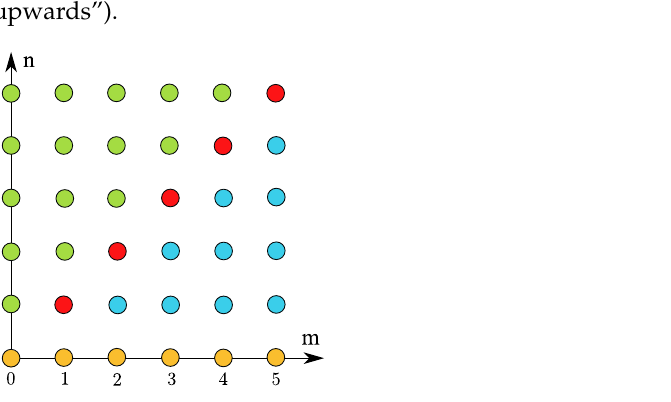
Figure 4. Topological phase diagram of the system described by the Hamiltonian (1) characterized by the “winding number” C , given by Equation (20), depending on parameters ( n , m ) ∈ { 0,1,2,3, . . . } and γ ∈ R + . (0) n = 0, ∀ m (orange): the trivial phase, C = 0; (I) m < n (green): C = − n /2; (II) m > n (cid:104) (cid:105) (cid:112) (blue): C = − n ; (III) m = n (cid:54) = 0 (red): C = − n 1 + 1/ 1 + γ 2 /2. Along the m = n > 0 line, C is a function of γ which interpolates between values of C in the regions I and II, being equal to the value in I in the limit γ → ∞ , and equal to the value in II in the limit γ = 0.